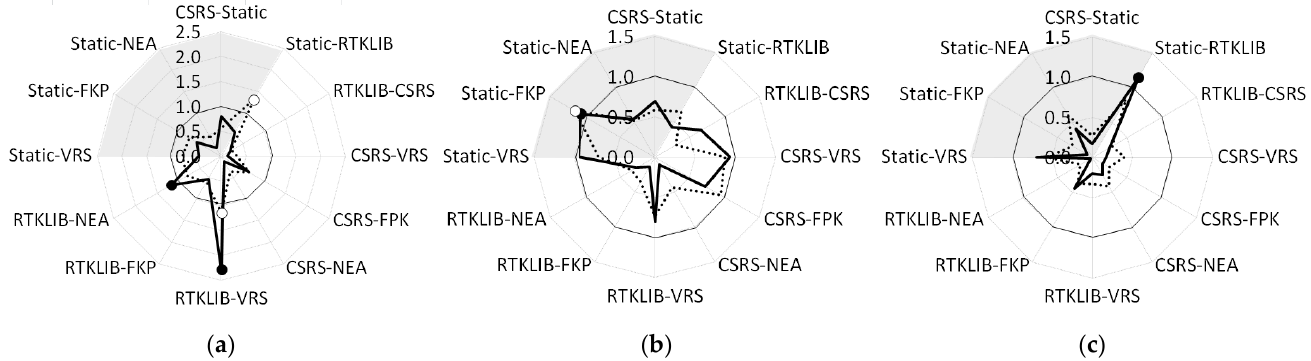
Figure 7. Normality tests applied on the frequencies of: ( a ) ∆ N; ( b ) ∆ E and ( c ) ∆ h. The ratio between KS and KSC based on